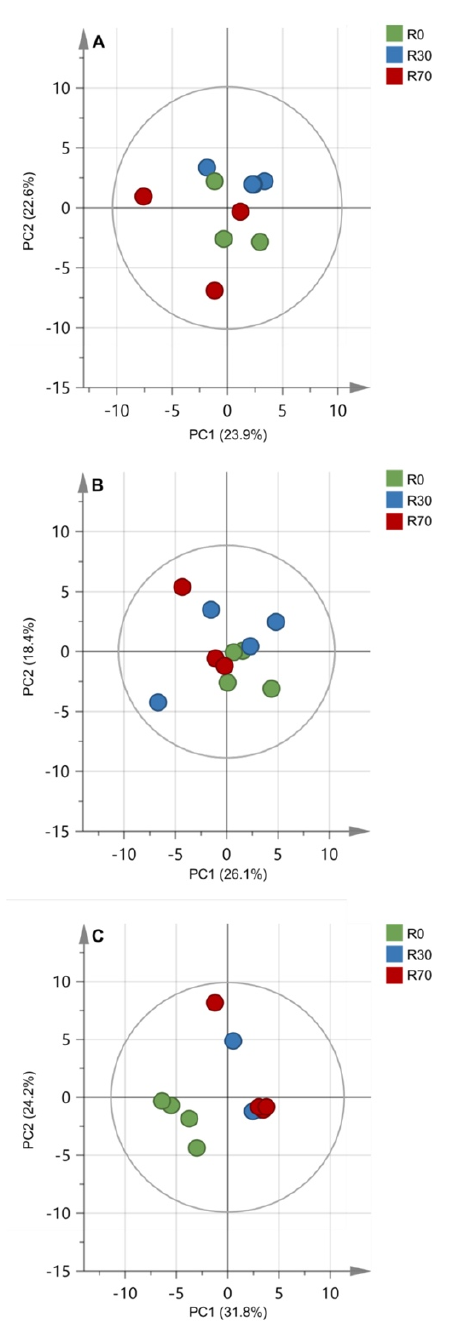
Figure 6. Principal component analysis of mature grape berry metabolic compounds in three vintages, 2018 ( A ), 2019 ( B ), and 2020 ( C ). Score plots of UPLC–MS-based metabolomic data from ethanolic extracts of berries under different irrigation treatments: R0 = non—irrigated plants; R30 = deficit irrigation corresponding to 30% of evapotranspiration; R70 = deficit irrigation corresponding to 70% of evapotranspiration.